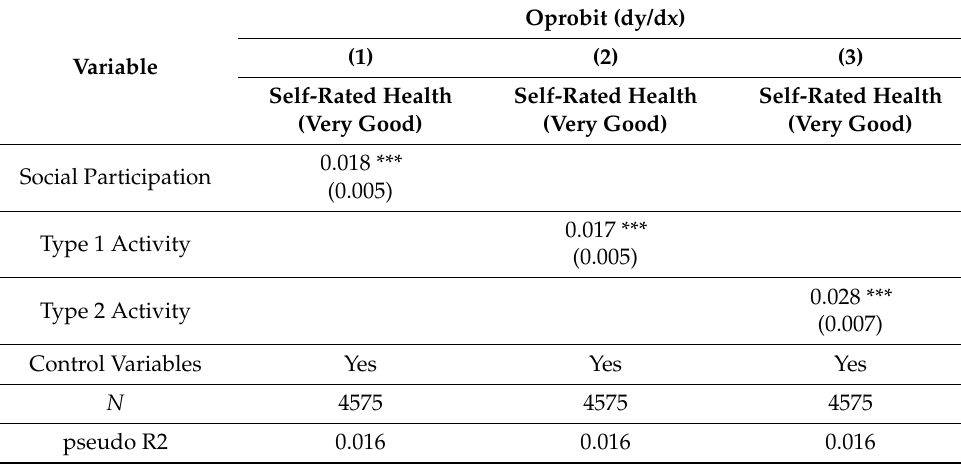
Table 4. Different types of social participation and self-rated